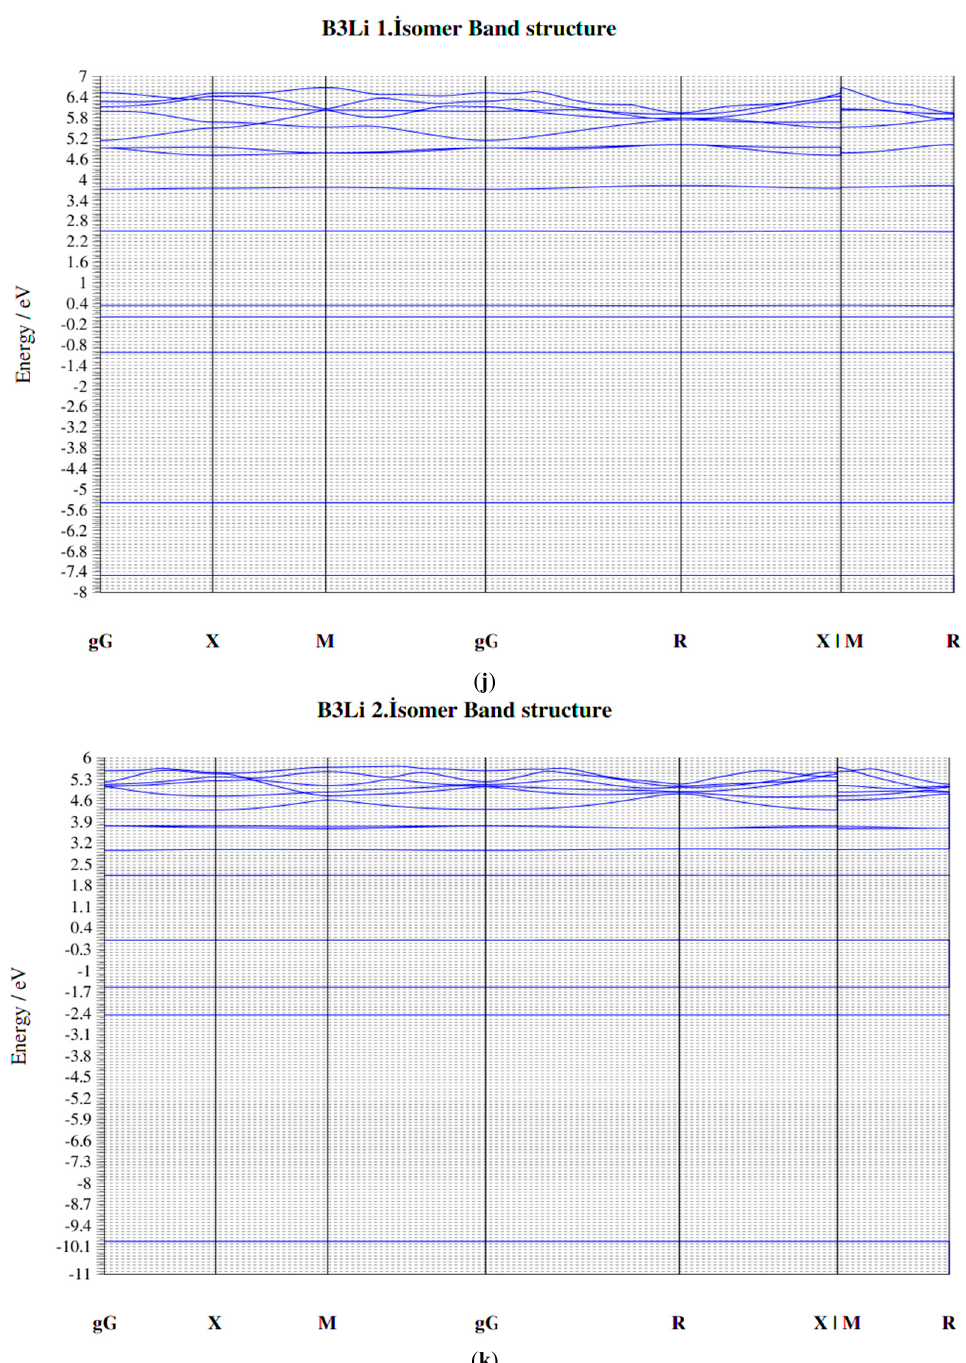
Figure 9. (a – k). The B x Li y (x = 1–3, y = 1–3) clusters of the Band Structure. Figure 9. ( a – k ). The B = 1–3, y = 1–3) clusters of the Band x Li y (x